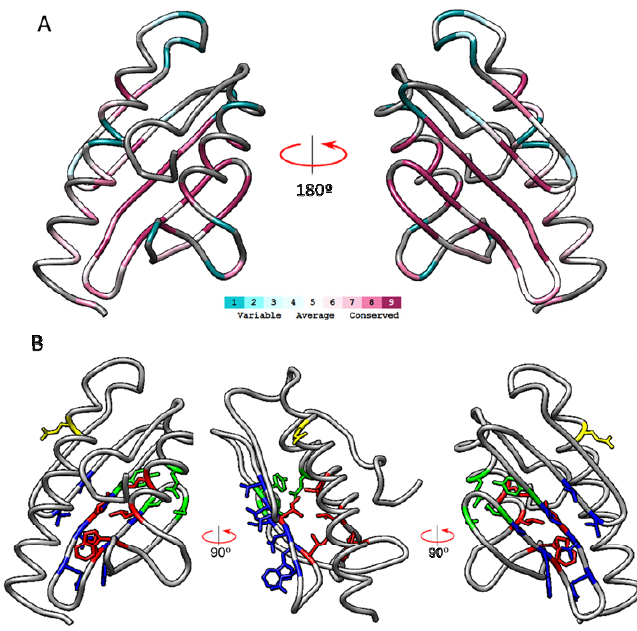
Figure 1. Frataxin structure (PDB ID:3S4M) indicating the conserved amino acids identified in ConSurfID35 analysis. In ( A ), frataxin structure is shown in ribbons and colored according to the conservation scores calculated by ConSurf. In ( B ), highly conserved amino acids (ConSurf score = 9) are shown in sticks and colored according to the four conservation clusters defined: cluster 1 red, cluster 2 blue, cluster 3 green, and cluster 4 yellow.